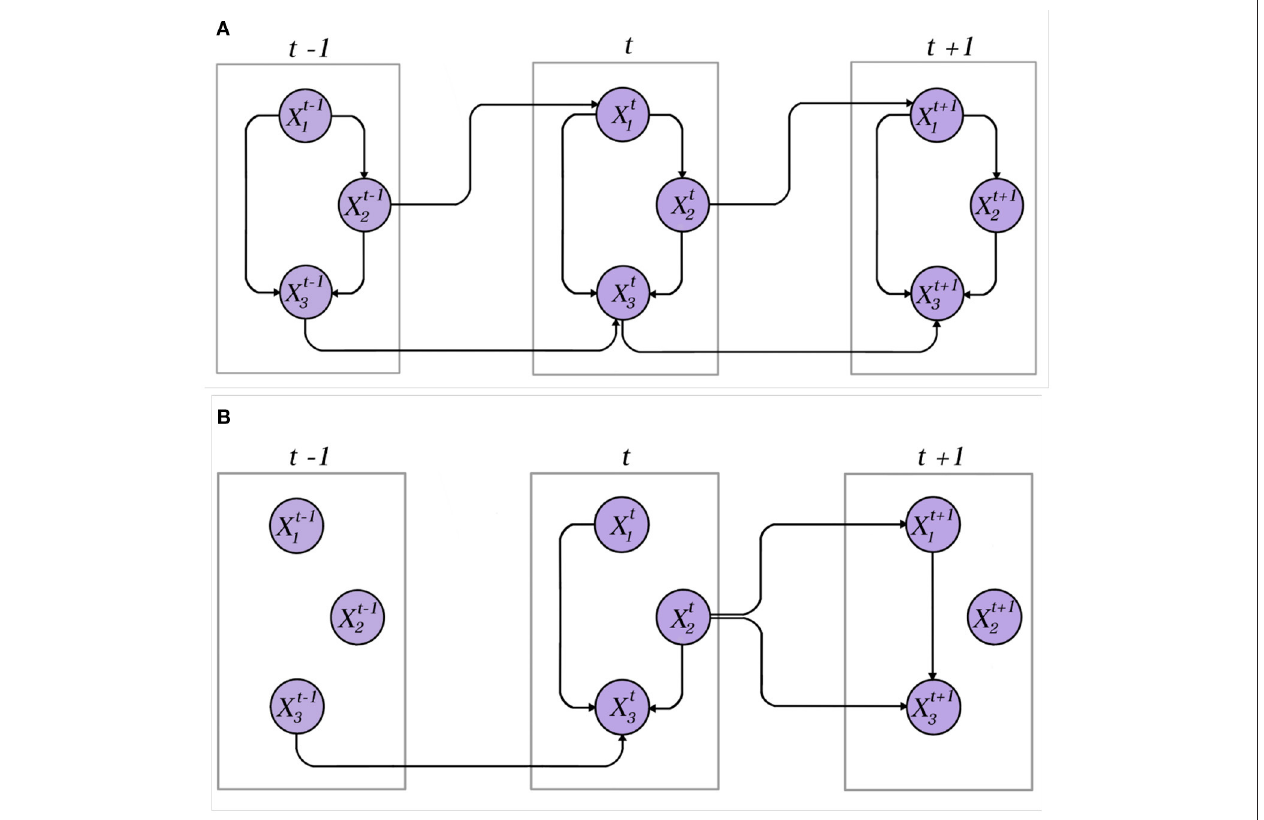
FIGURE 1 | Examples of DBNs. (A) A dynamic network in which all variables are represented by stationary time series. The connections between variables within a time slice and in the in-between of time slices are preserved. (B) A dynamic network over non-stationary data. The connections between variables and in the in-between of time slices become obsolete and changes over